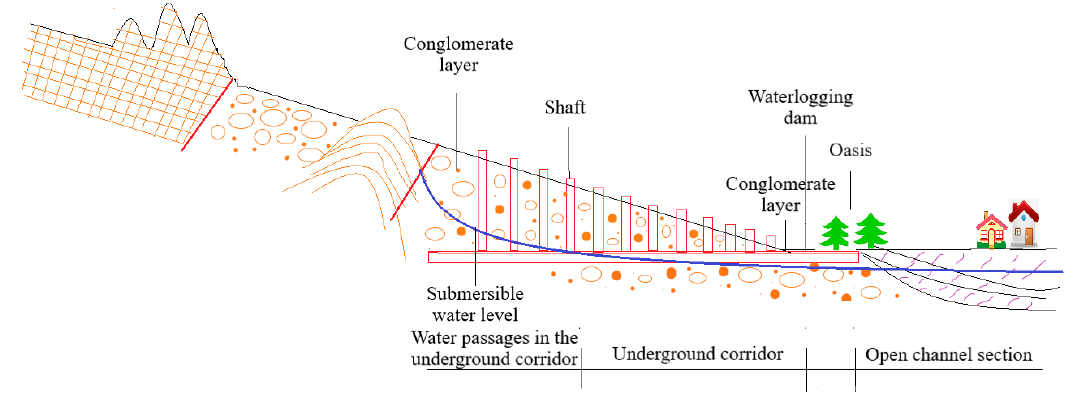
Figure 6. Schematic diagram of Karez well structures. Table 4. Water quality monitoring and evaluation of the Karez project in Lianmuqin town.